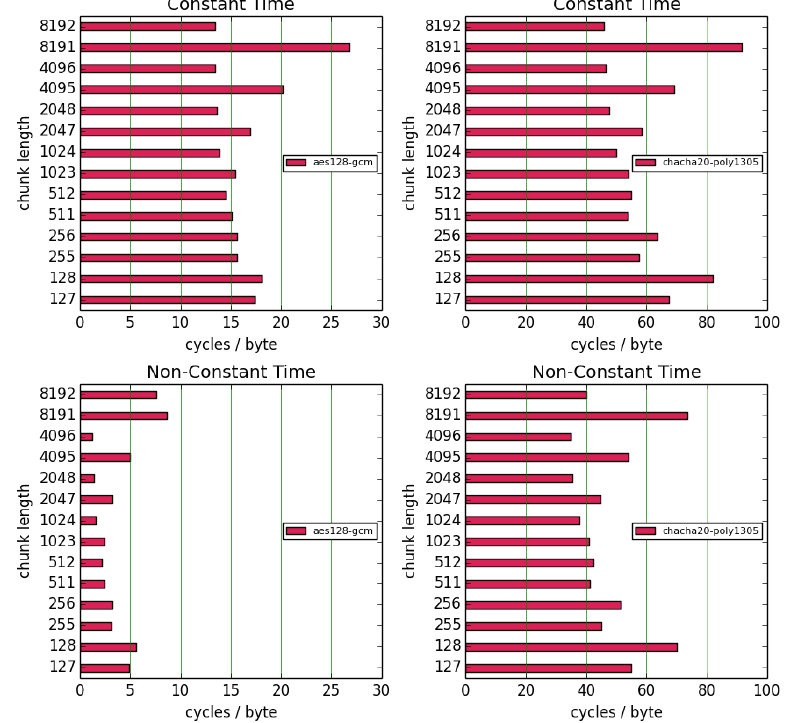
Figure 14: Comparing the cost of decryption using constant-time and non-constant-time padding removal in libInterMAC , with AES - GCM and ChaCha20 - Poly1305 as internal nonce- based AE schemes. The constant-time option involves a significant performance penalty, especially for AES - GCM